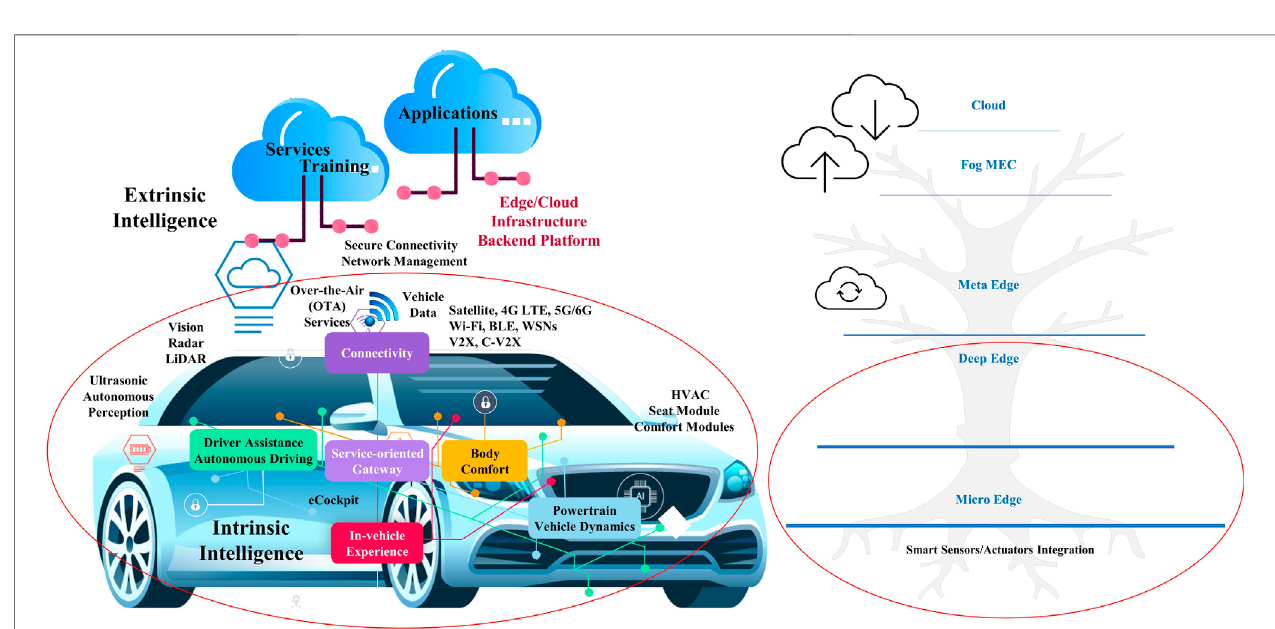
FIGURE 14 | Intrinsic and extrinsic intelligence for ECAS vehicles.